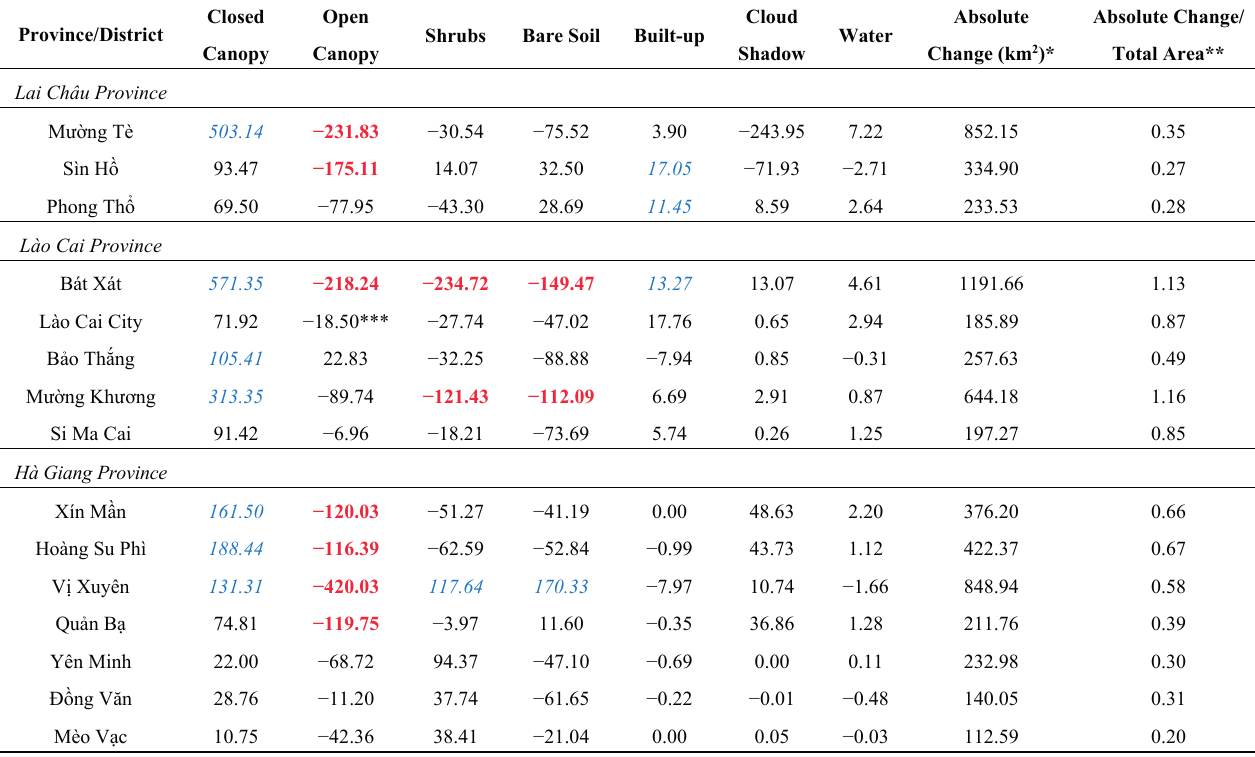
Note: Blue italics and red bold values: important increases and decreases, respectively. * Absolute change is the sum of absolute values of each LULCC, excluding areas covered by cloud/shadow . ** Total areas do not include cloud/shadows . *** The change in open canopy class in Lào Cai city is numerically small, but was 37.83 percent of the total open canopy area in